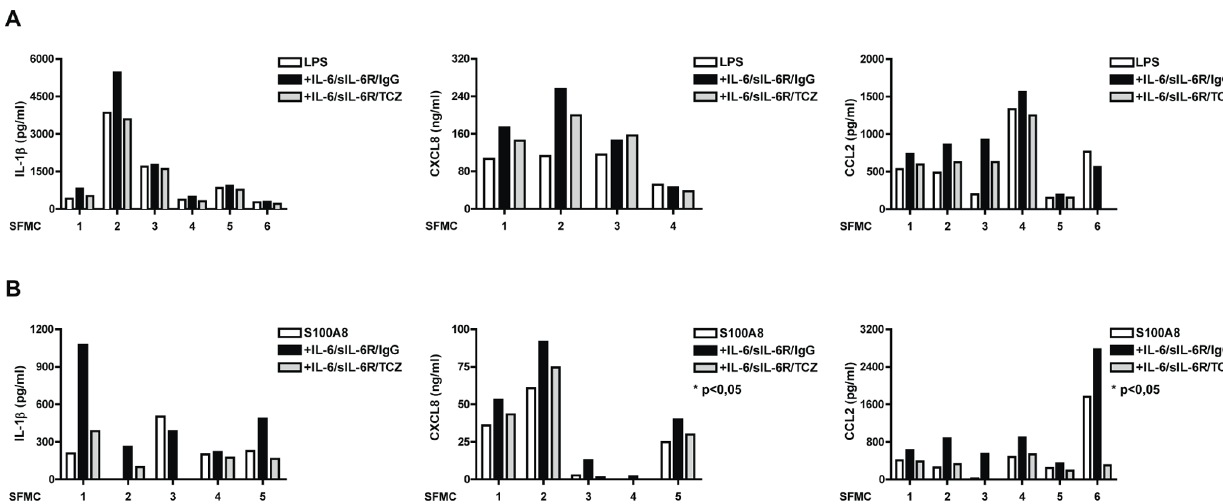
Figure 6. Exposure to IL-6 enhances cytokine and chemokine production in SFMC. SFMC were left to adhere on plastic for 3 hours in DMEM supplemented with 10% fetal calf serum (FCS). SFMC were pre-exposed to IL-6/sIL-6R in combination with IgG1 or with TCZ for 1 hour. Cells were then stimulated for 18 hours with LPS (10 ng/ml) ( A ), and S100A8 (5 m g/ml) ( B ). IL-1 b , CXCL8 and CCL2 levels were measured by ELISA. *p , 0.05 for values from IL-6/sIL-6R -stimulated compared with NT cells.